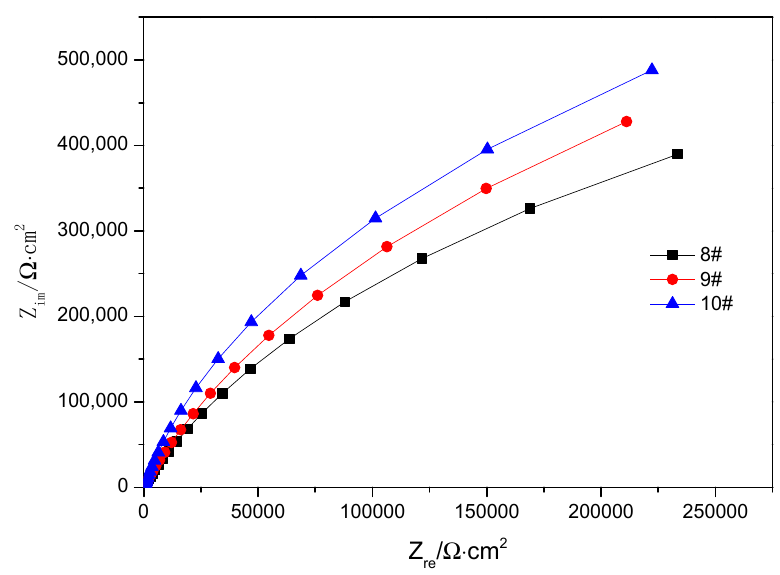
Figure 10. Surface impedance mapping on the surface of 2205 duplex stainless-steel.